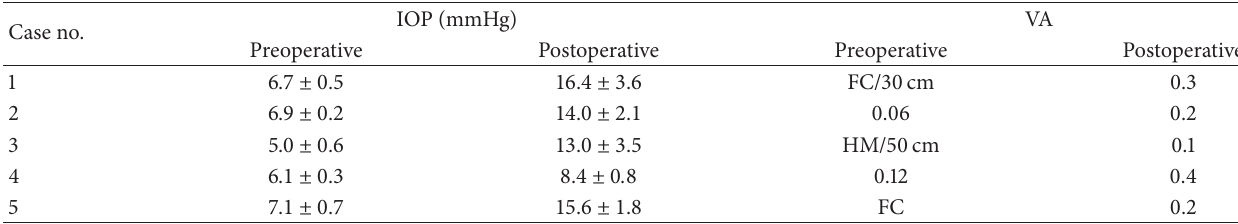
Table 2: IOP and VA of the five patients with cyclodialysis clefts.